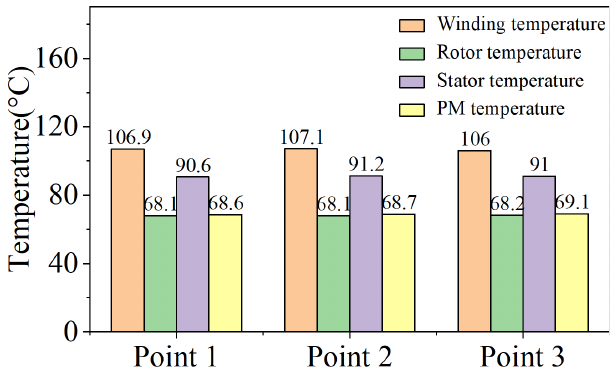
Figure 14. Comparison diagram of winding temperature, rotor temperature, stator temperature and PM temperature of candidate points.